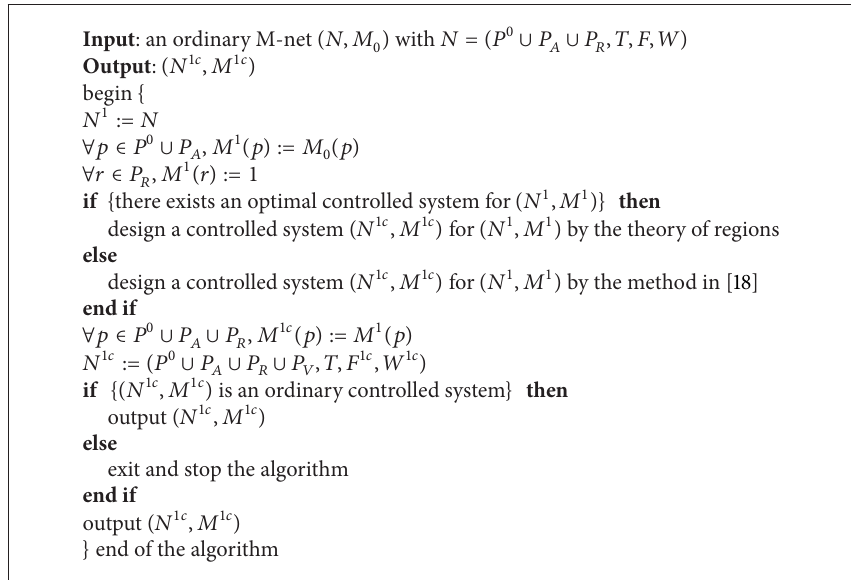
Algorithm 1: Structure design of a controlled system for (𝑁, 𝑀 0 )